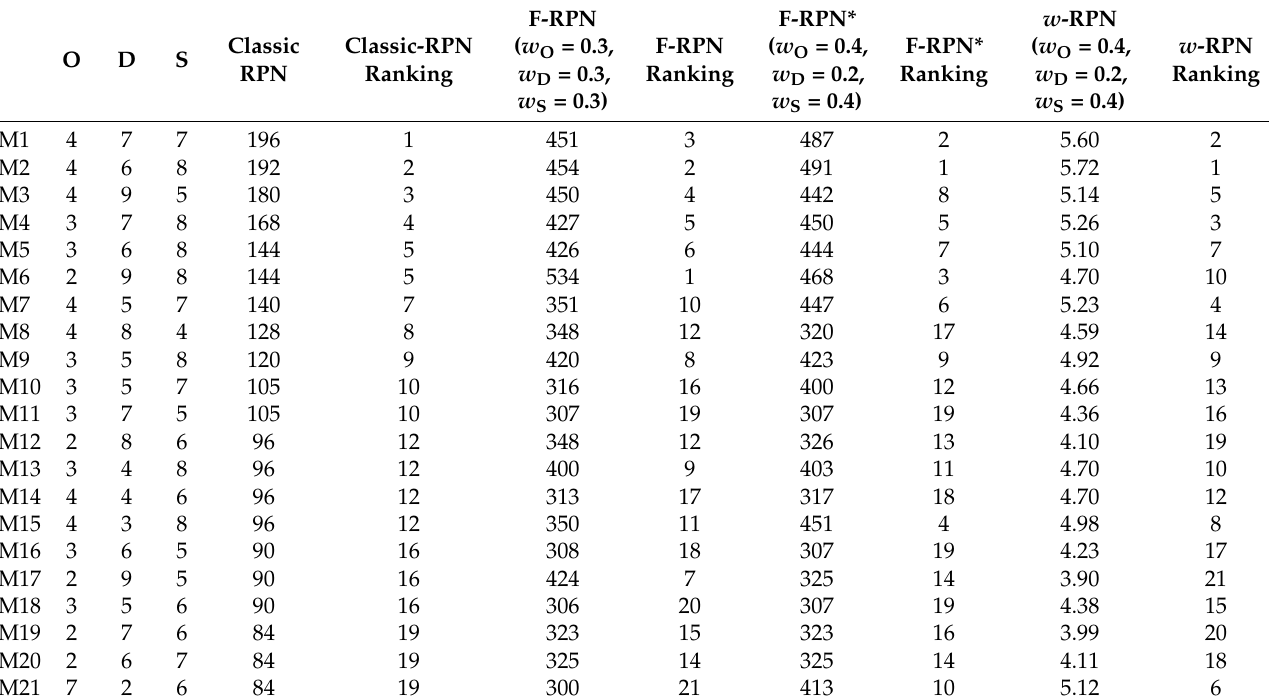
Table 1. Comparison among failure mode ranking obtained by different FMECA approaches.